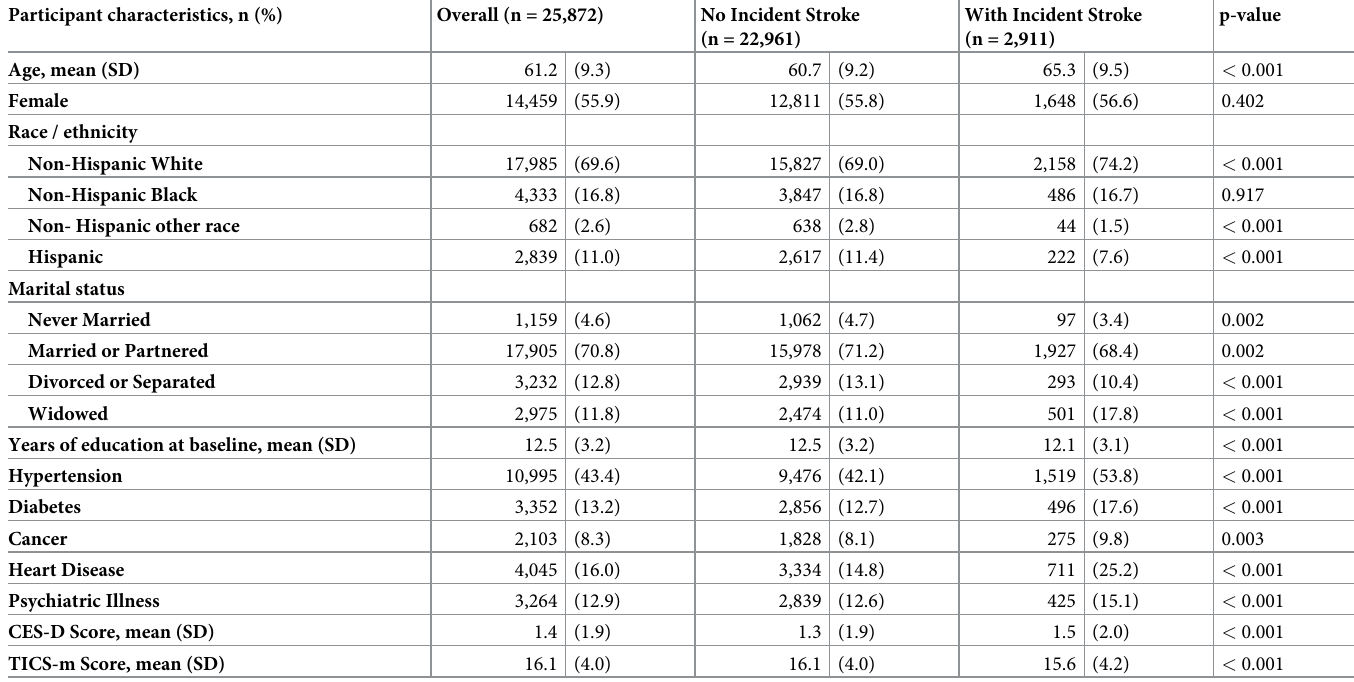
Table 1. Participants’ baseline characteristics by stroke